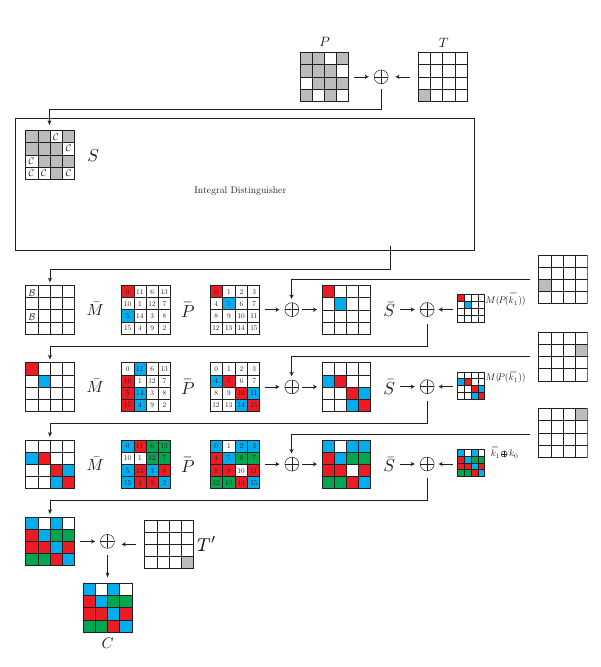
Figure 25: Key-recovery attack on Mantis 4 , 8